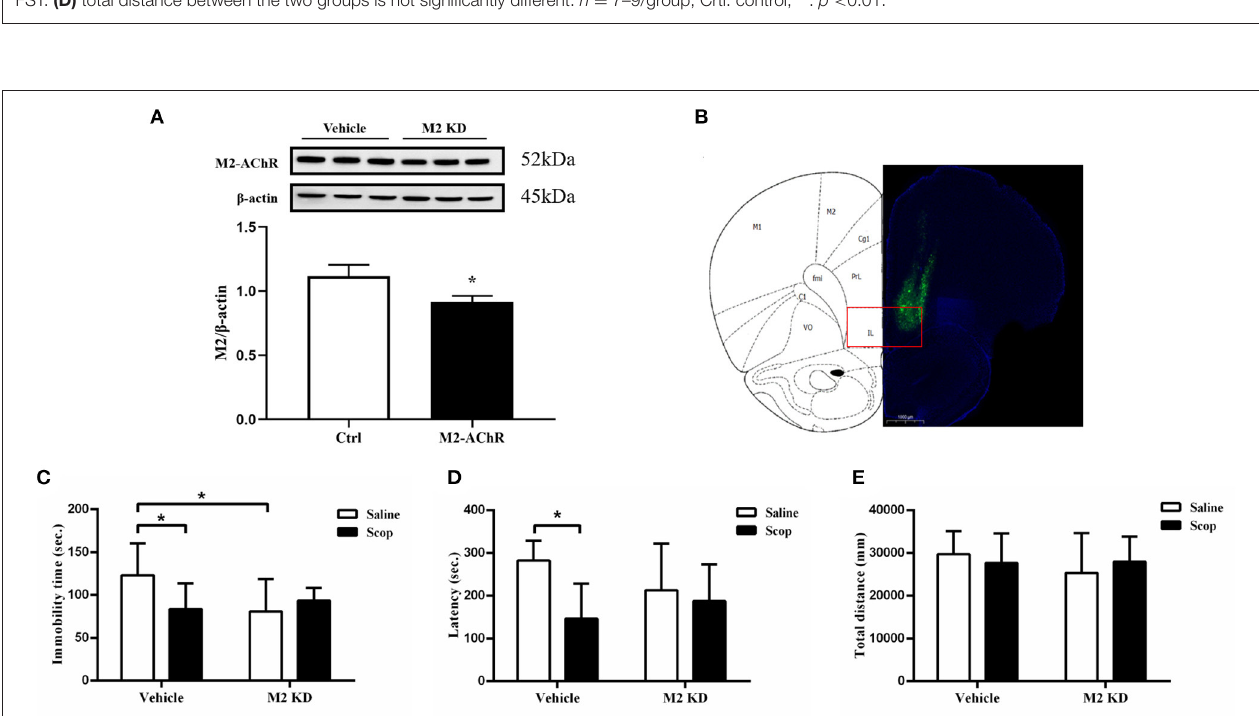
FIGURE 3 | Effects of MCT and 4-DAMP on animal behavior. (A) using 1 µ g/ µ l MCT to block M2-AChR in the mPFC significantly reduces the immobility time in the FST. (B) total distance between the two groups is not significantly different. (C) using 4-DAMP to block M3-AChR cannot significantly reduce the immobility time in the FST. (D) total distance between the two groups is not significantly different. n = 7–9/group; Crtl: control; **: p < 0.01.